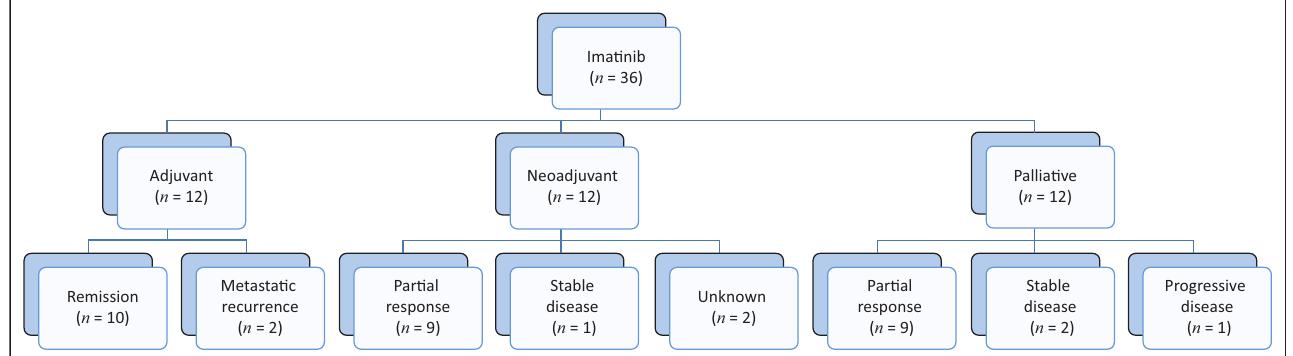
FIGURE 3: Imatinib indications and objective